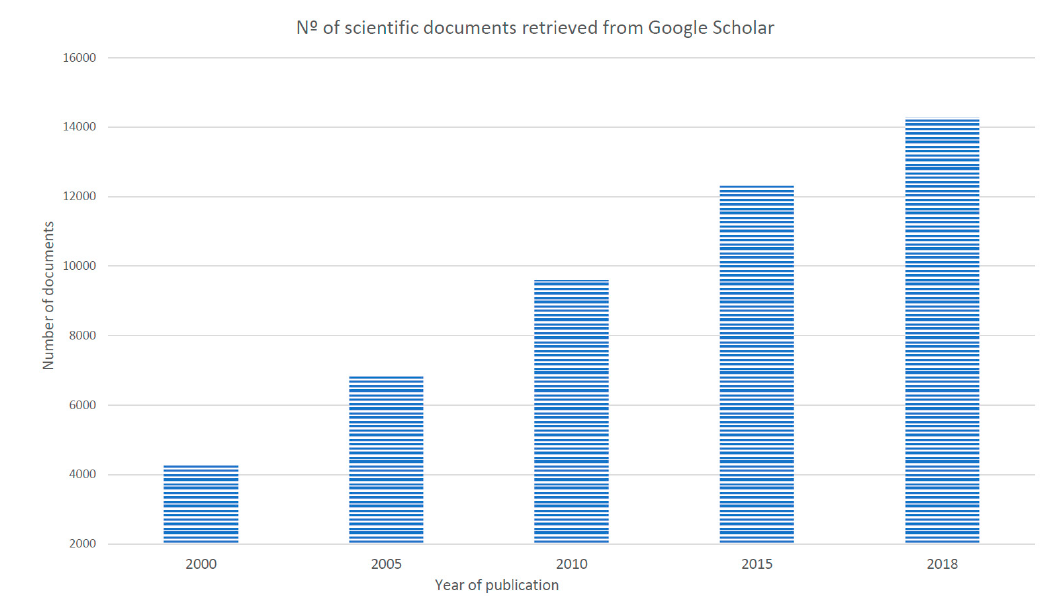
Figure 1. Number of scientific documents retrieved with RTW as keyword.